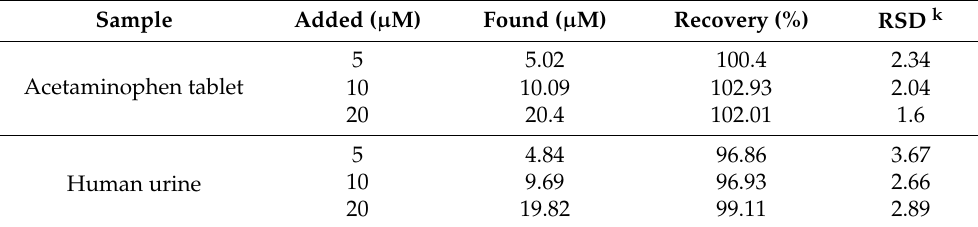
Table 2. Determination of APAP in real samples using AgCuO NPs/fCNTs/SPCE. Sample Added ( µ M) Found ( µ M) Recovery (%) RSD k Acetaminophen